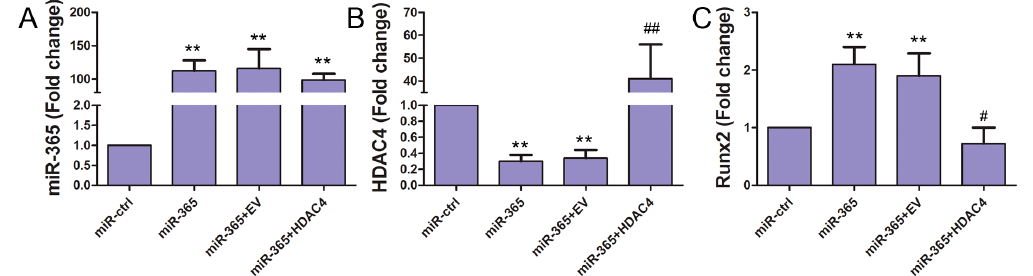
Figure 6. MiR-365 increased Runx2 expression and Histone deacetylase 4 (HDAC4) over-expression inhibited this effect of miR-365. The MC3T3-E1 cells were co-transfected with miRNA mimic control (miR-ctrl); miR-365 mimic (miR-365); miR-365 and a cDNA plasmid empty vector (EV) (miR-365+EV); miR-365 and a vector containing HDAC4 cDNA (miR-365+HDAC4). The day before transfection, MC3T3-E1 cells were cultured to 80% confluence. Transfection was performed using Lipofectamine 3000 (Invitrogen) according to the manufacturer’s instructions. 48 h after transfection, RNA levels of miR-365 ( A ), HDAC4 ( B ), and Runx2 ( C ) was quantified by qPCR. n = 3. ** p < 0.01 compared to miR-ctrl; # p < 0.05, ## p < 0.01 compared to miR-365+EV.